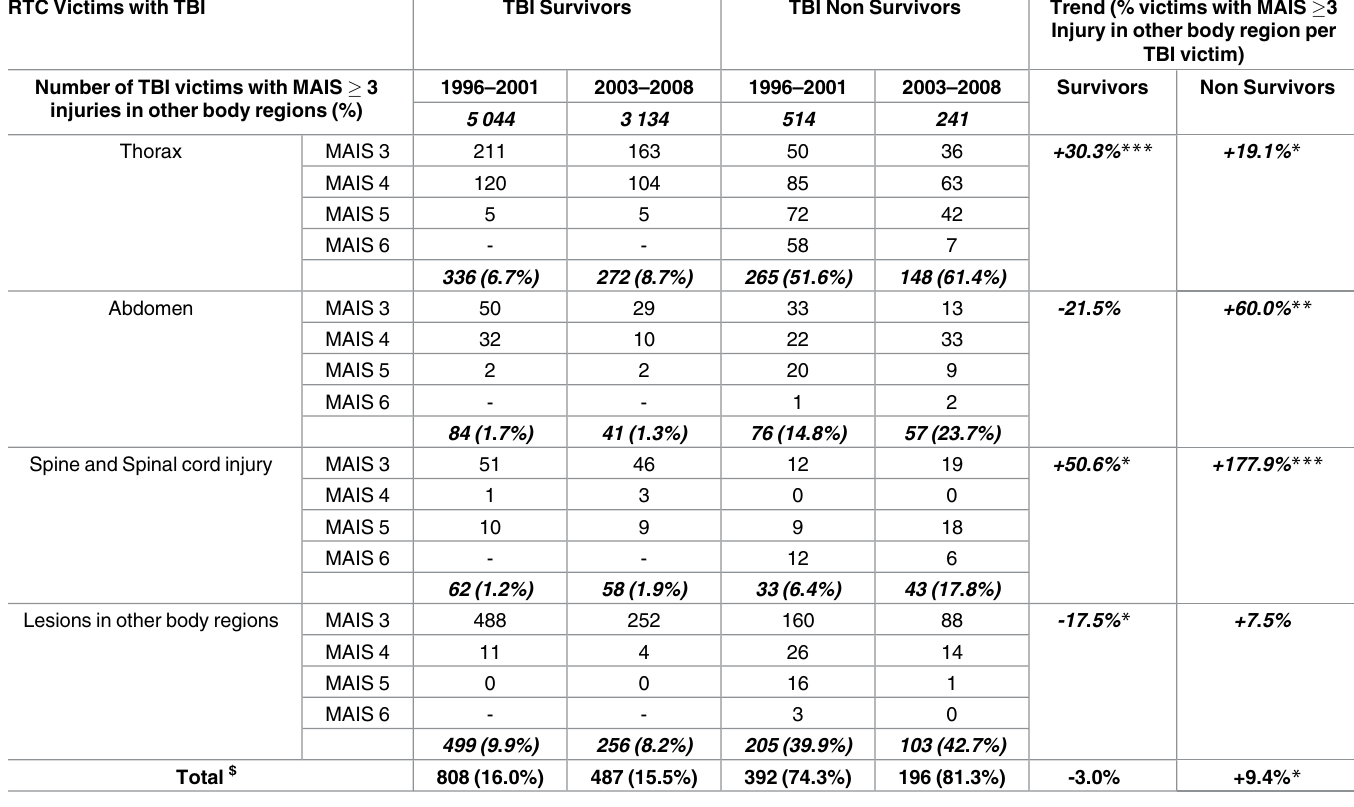
* means p < 0.05 for the corresponding